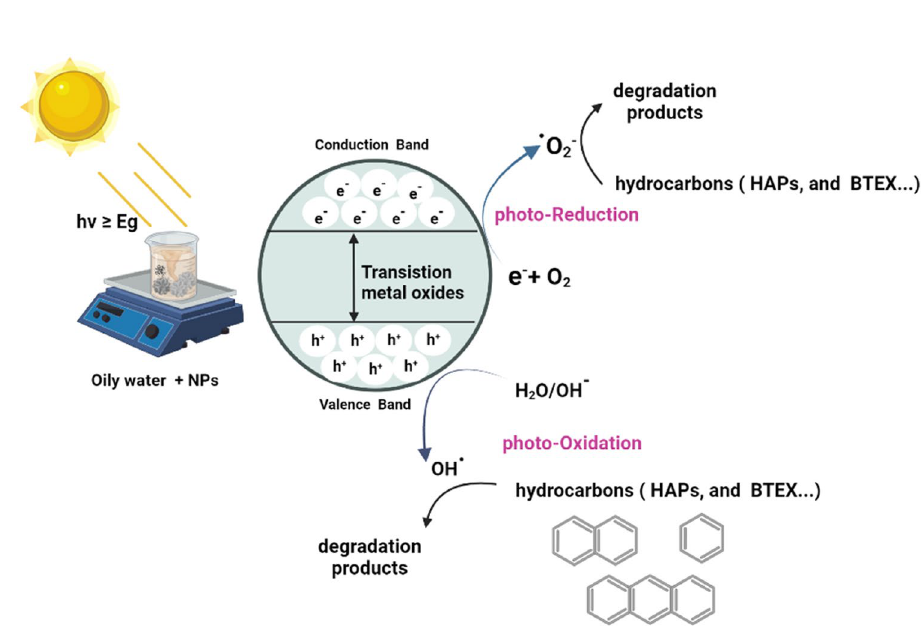
Figure 10. Mineralization mechanism by photodegradation of hydrocarbons (oily water) using